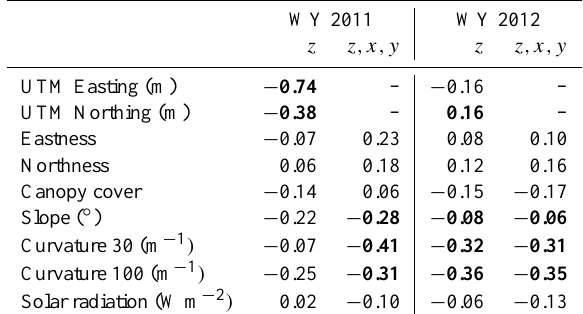
Table 4. Partial correlations between SWE and terrain/canopy vari- ables with the effect of elevation ( z ), UTM Easting ( x ), and UTM Northing ( y ) removed. Bolded values represent statistical signifi- cance ( p